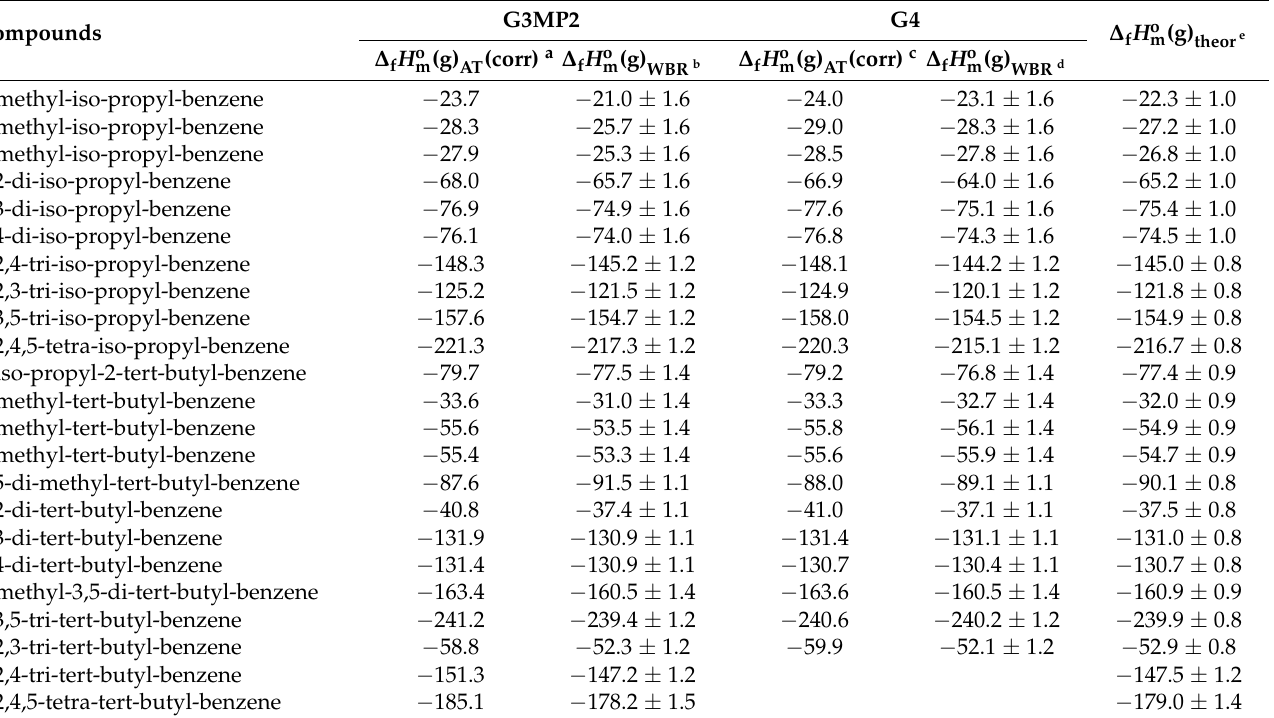
Table 10. Calculation of the theoretical gas-phase enthalpies of alkylbenzenes at T = 298.15 K ( p ◦ = 0.1 MPa, in kJ · mol − 1 ) a